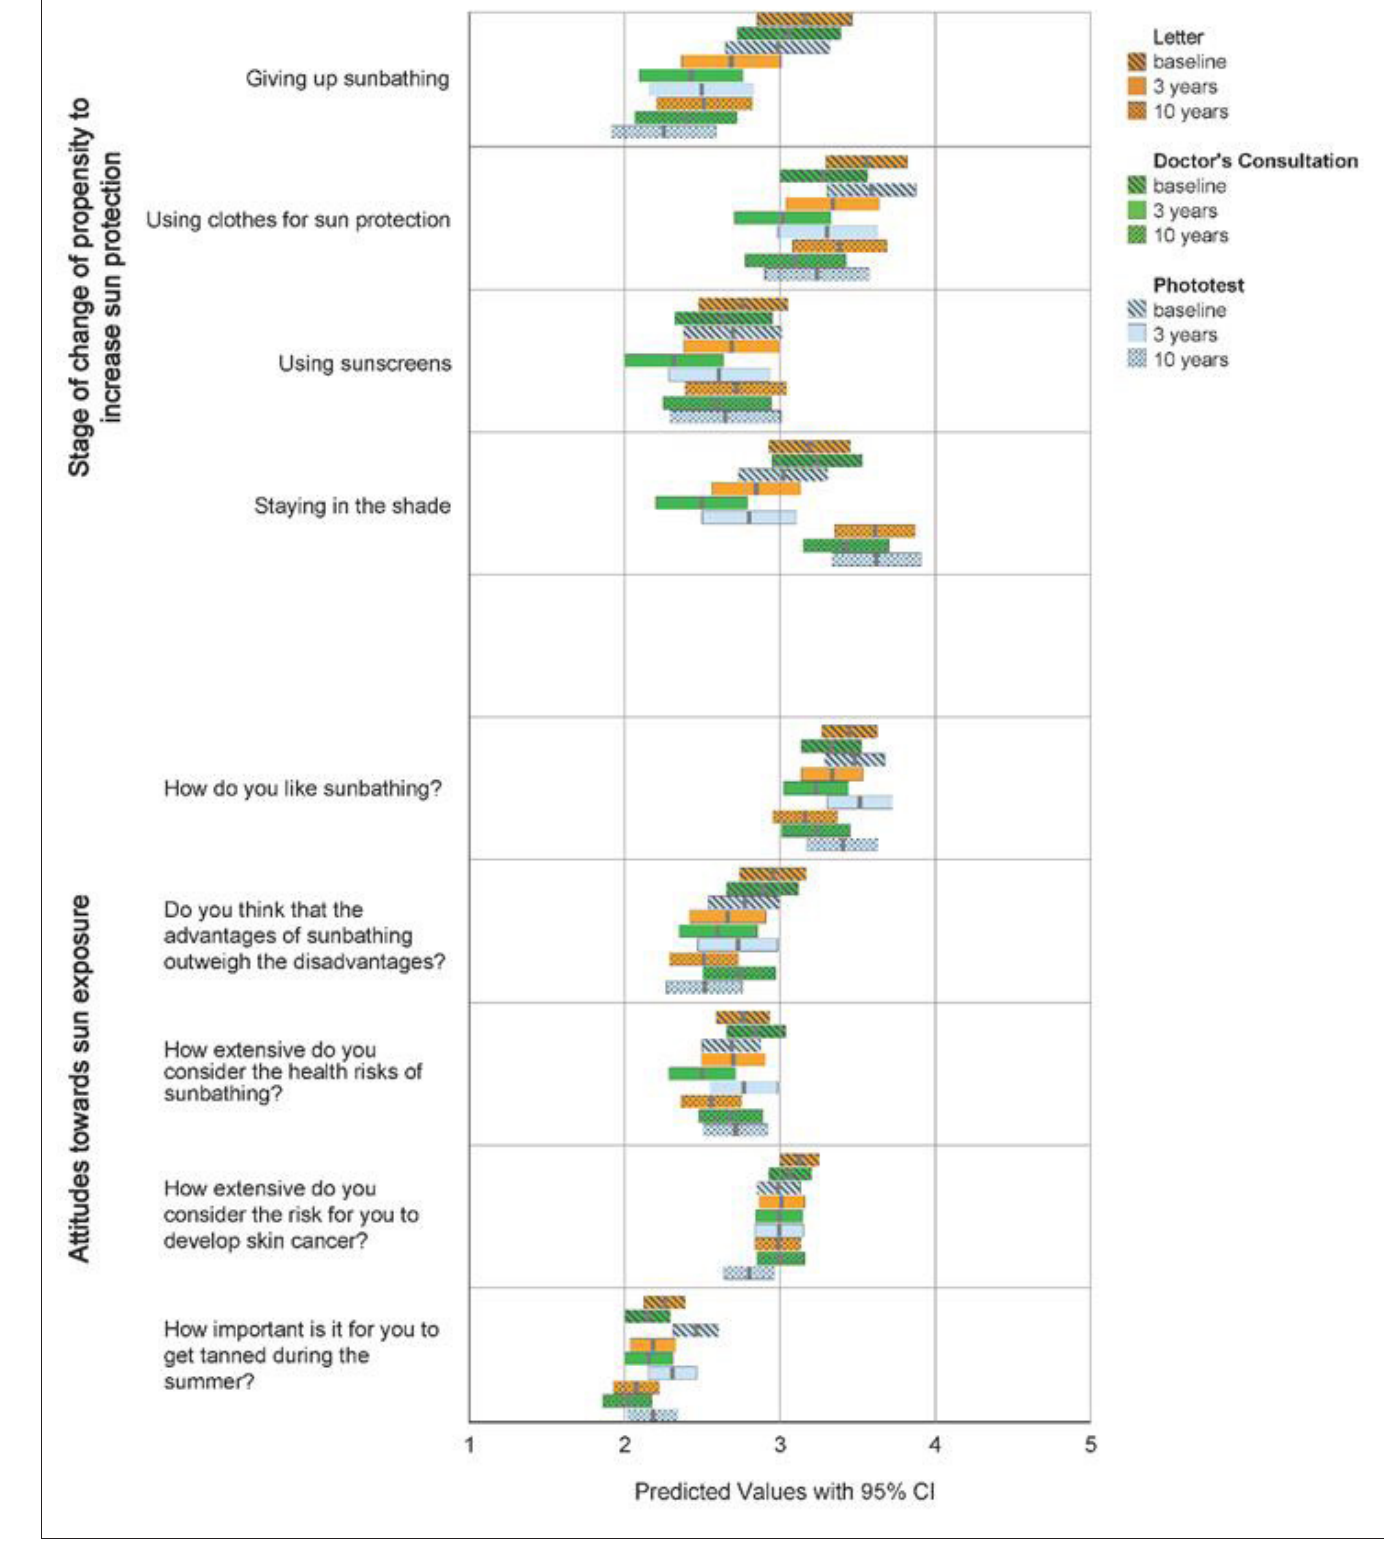
Figure 3 Predicted mean response values with 95% CI for each of the questions addressing stage of change of propensity to increase sun protection (A), and the questions regarding attitudes towards sun exposure (B), at baseline and at 3 and 10 years follow-up, in each of the three intervention